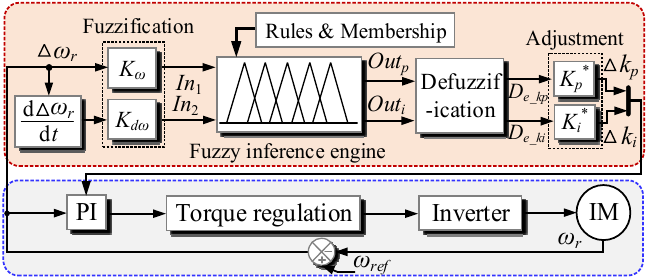
Figure 1. Block diagram of traditional fuzzy adaptive speed PI controller used for IM control.